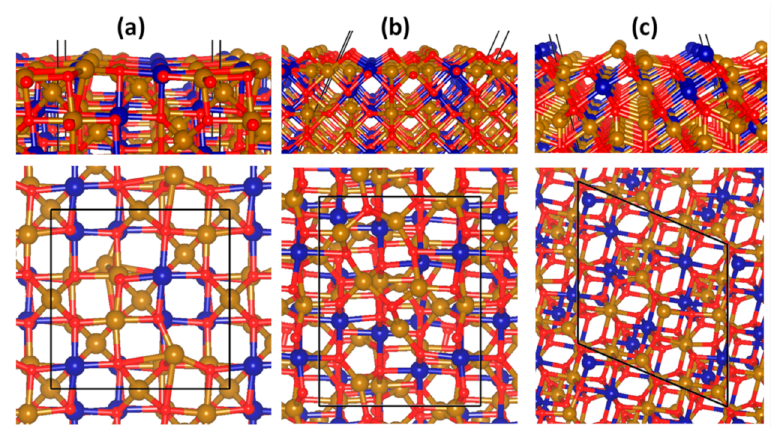
Figure 2. Optimised structures of the naked ( a ) (001), ( b ) (110), and ( c ) (111) surfaces of Fe 2 CoO 4 side (up) and top (down) views (atomic colour: Fe = brown, Co = blue, O = red).